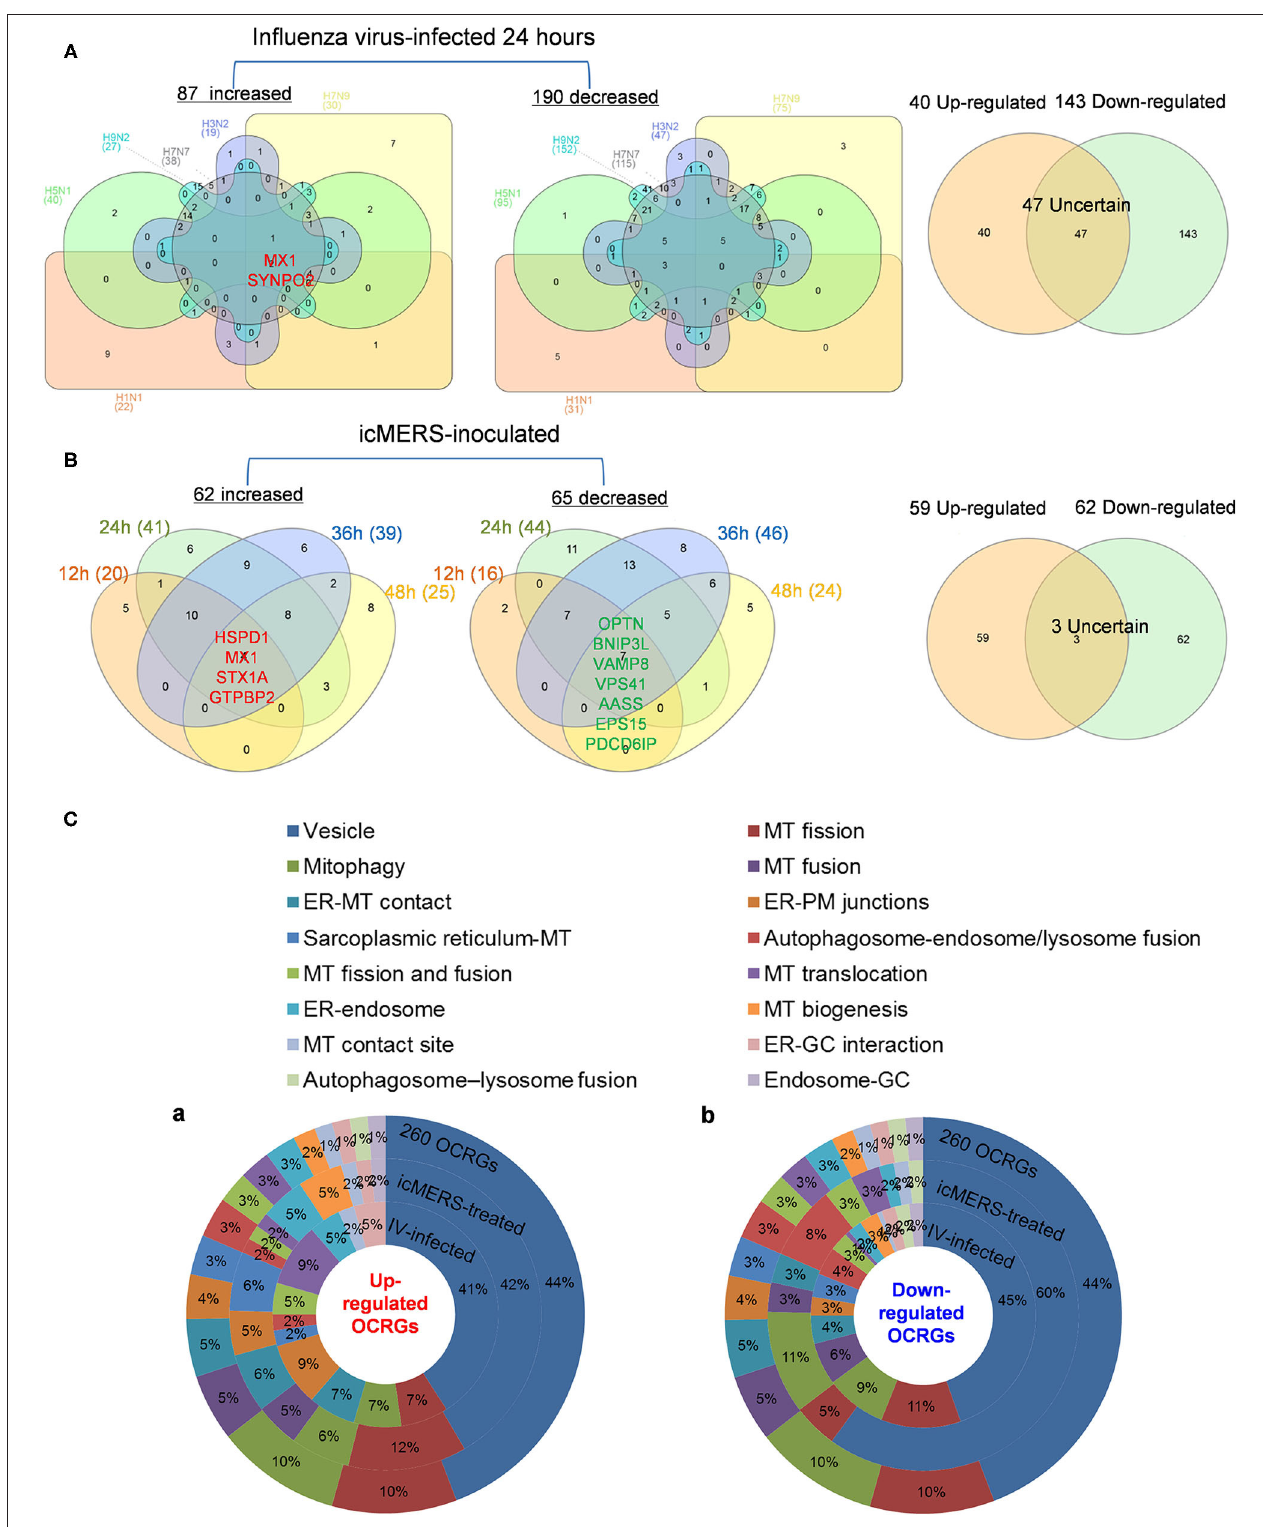
FIGURE 6 | More OCRGs were significantly expressed in influenza virus- and icMERS-inoculated cells. (A) In H1N1-infected human microvascular endothelial cells, H7N9-, H7N7-, H5N1-, and H3N2-infected Calu-3 cells and H9N2-infected human umbilical vein endothelial cells, MX1 and SYNPO2 were the common upregulated OCRGs shared by these six types of flu virus-treated cells; no common downregulated genes were shared by these six flu virus-treated cells. When the overlapped 47